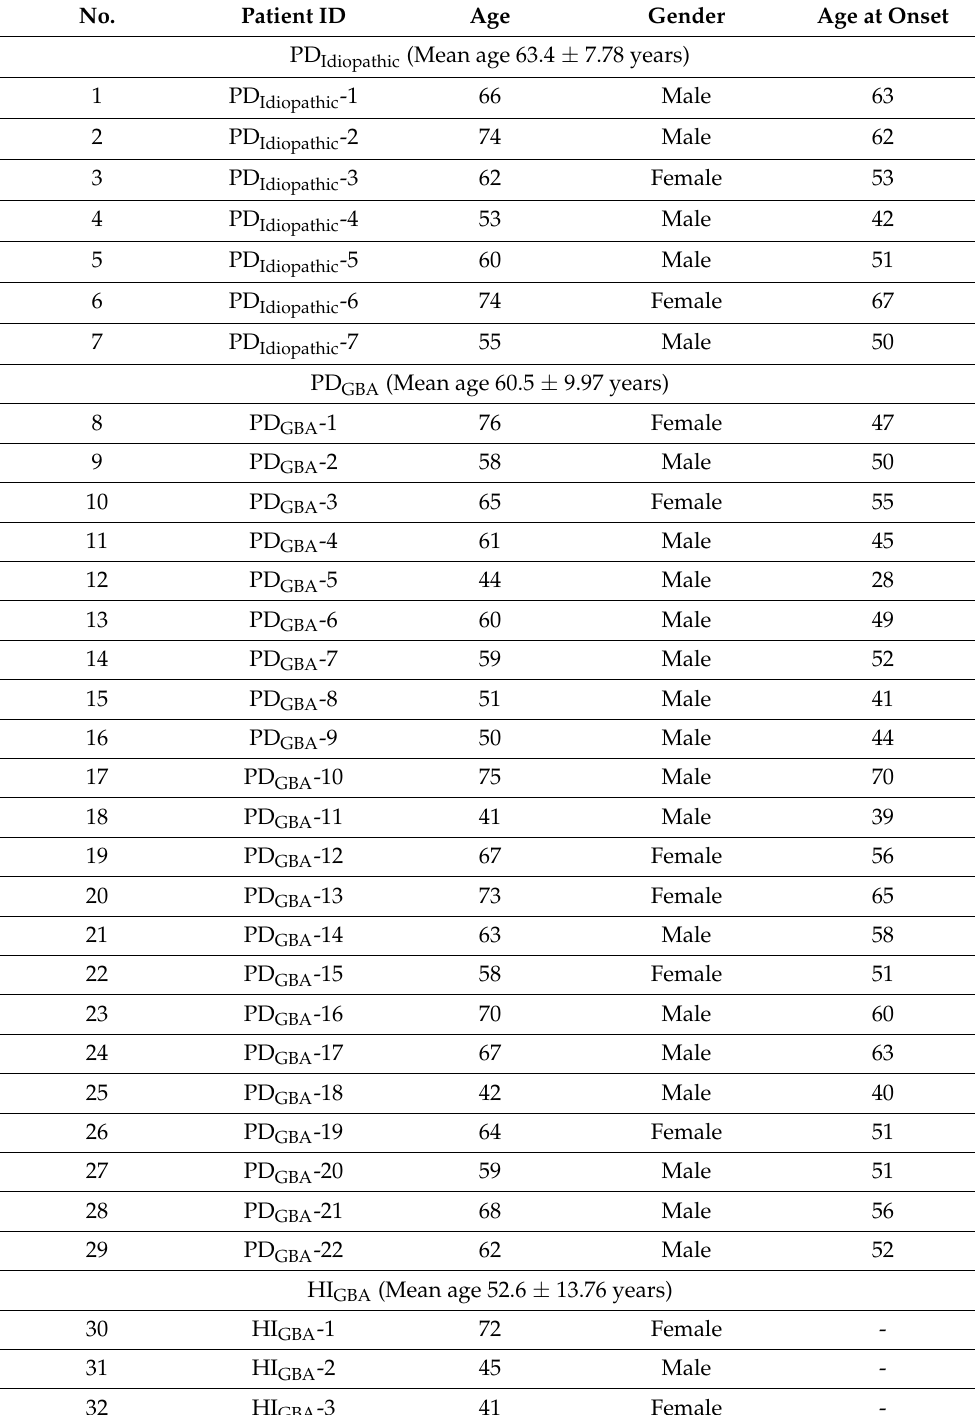
Table 1. List of samples used in the study. A total of 32 CSF samples were used for the study including 22 PD cases with GBA mutation (PD GBA ), 7 PD cases without mutations (PD Idiopathic ), and 3 healthy controls with GBA mutation (HI GBA